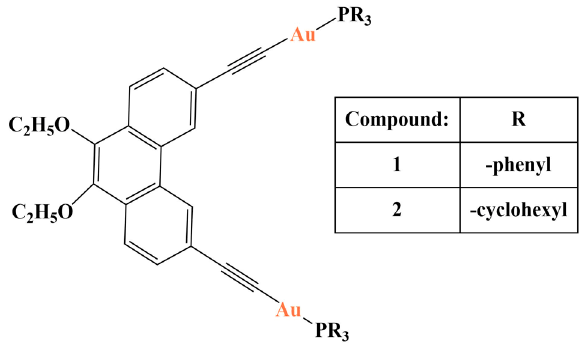
Figure 28. The complexes presented in [110].